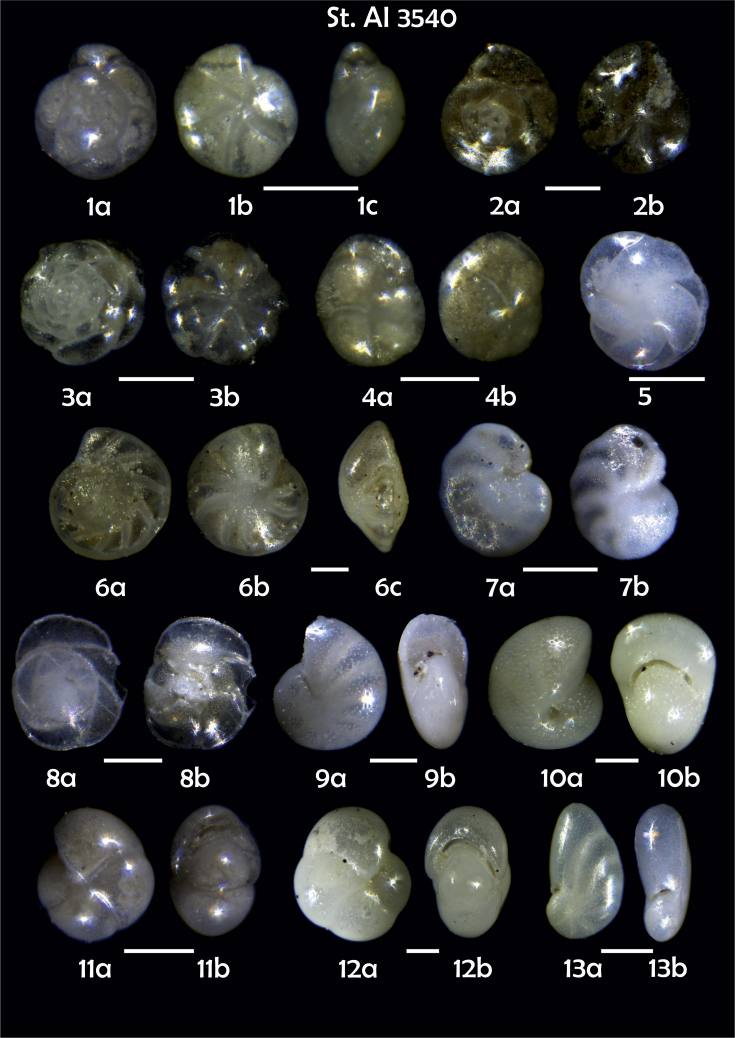
Station 35401Oridorsalis umbonatus, a spiral view, b umbilical view, c apertural view. 2Epistominella exigua,a spiral view, b umbilical view. 3Alabaminella weddellensis, a spiral view, b umbilical view. 4Cassidulina reniforme, a apertural view, b lateral view. 5Cassidulina laevigata. 6Cibicidoides sp. cf. C. pachyderma?, a umbilical view, b spiral view, c apertural view. 7C. lobatulus, a umbilical view, b spiral view. 8Gavelinopsis praegeri,a spiral view, b umbilical view. 9Melonis barleeanus, a side view, b apertural view. 10Melonis pompilioides, a side view, b apertural view. 11, 12Pullenia bulloides, a side view, b apertural view. 13Nonionella sp. cf. Nonionella turgida, a lateral view, b apertural view. 14Nonionella auricula. 15Pyrgo sp. 16, 17Triloculina trihedra, a, b lateral view. 18Brizalina subspinescens. 19Bolivina earlandi. 20Bulimina mexicana. 21, 22Trifarina angulosa. Scale 100 μm.